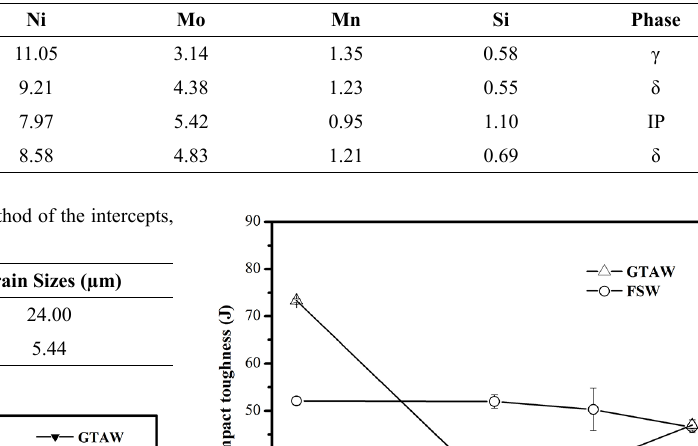
Figure 6. Images obtained by MEV from the microstructure of the thermally aged weld metals for 400 h. (a) GTAW, (b) FSW. Behara's etching. Table 12. Semi-quantitative chemical analysis determined by EDS of points selected of Figure 6(b) (% em peso). (%Fe = balance).